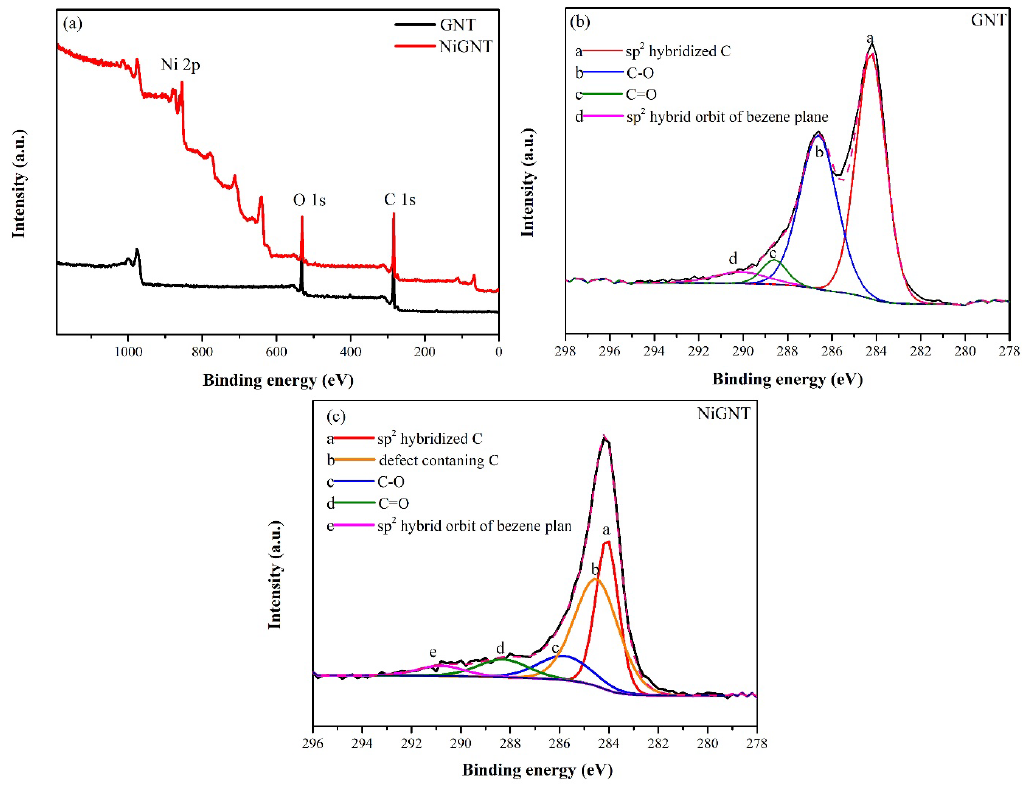
Figure 4. The XPS survey scan ( a ), and the deconvoluted C 1 s spectrum of GNT ( b ) and NiGNT ( c ) samples.